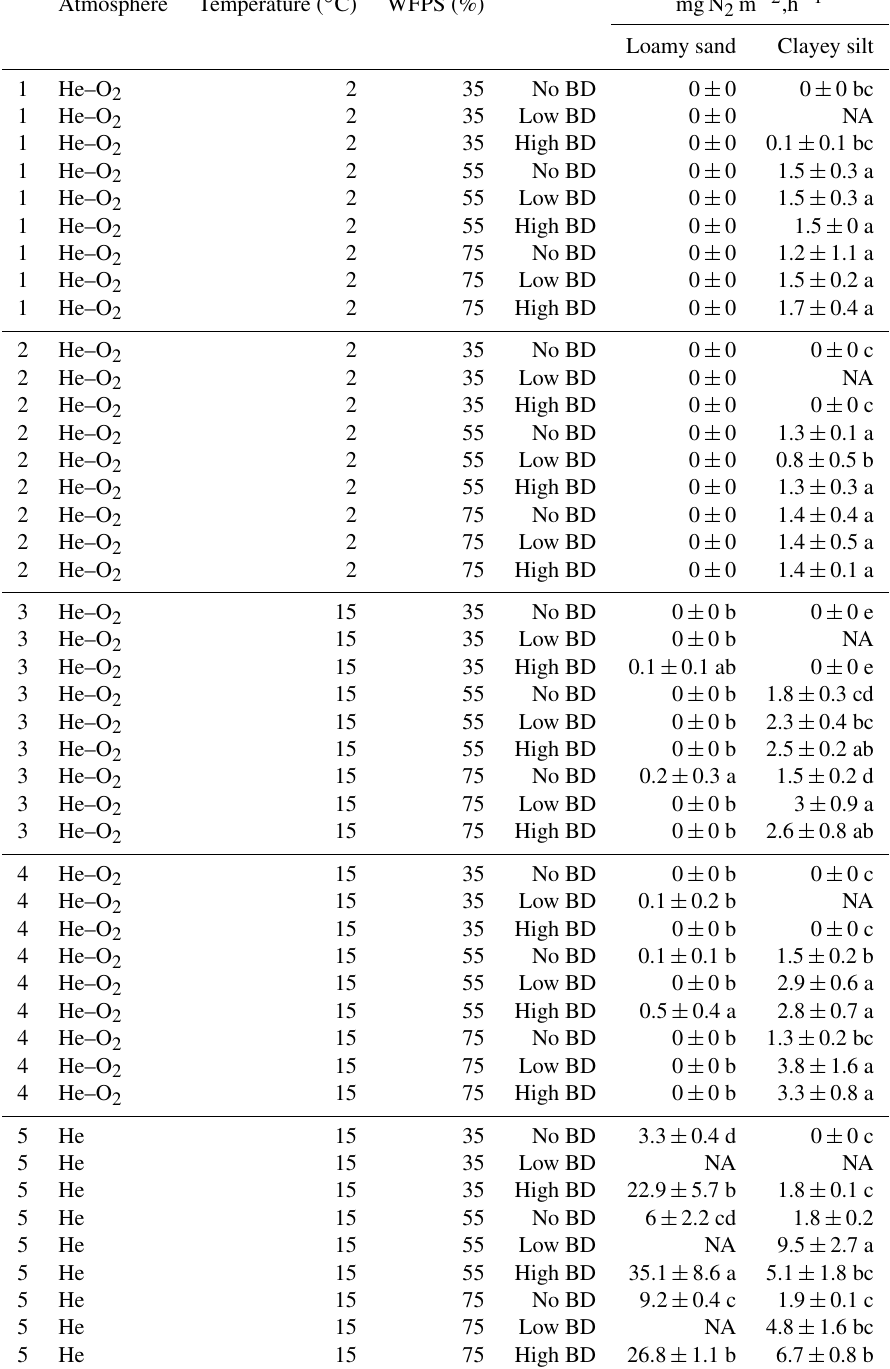
Table A3. Mean N 2 fluxes with standard deviations in mgm − 2 h − 1 from the loamy sand and the clayey silt, treated with different water- filled pore spaces (WFPSs, %), amounts of digestate (0mL per sample ring: no BD, 17.6mL: low BD and 35.2mL: high BD) and different temperature regimes ( ◦ C) under aerobic (He–O 2 ) and anaerobic (He) atmospheres. The column “Day” denotes the consecutive measuring days of the respective incubation cycle. Different letters after fluxes indicate significant differences (Tukey’s HSD, p < 0.05) within each soil and measuring day. Zeros as last digits were